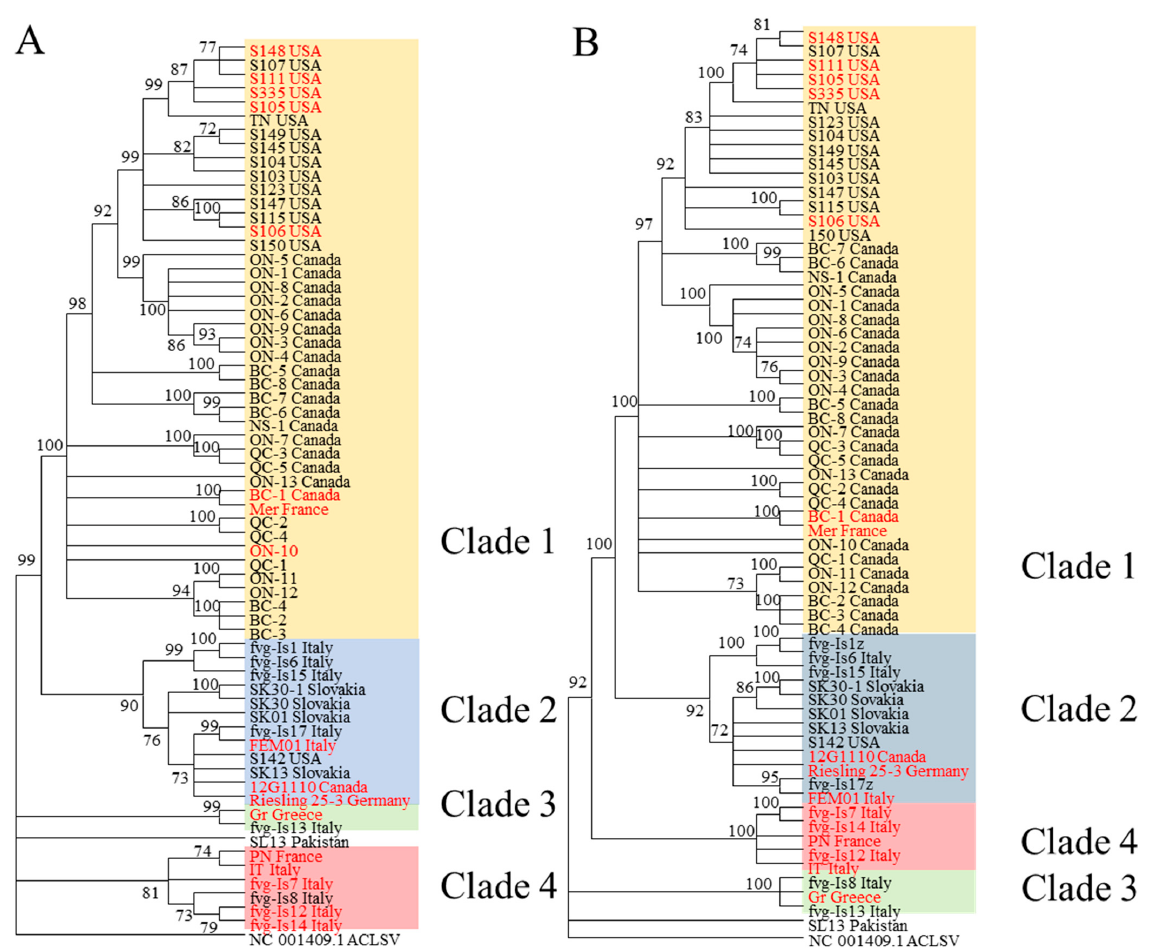
Figure 3. Maximum likelihood model for full genomes ( A /left) and the largest recombination-free fragments 4866 bp ( B /right) from 64 GPGV isolates. Both of these rooted bootstrap-consensus maximum likelihood trees were constructed with MEGA-X (General Time Reversal Model with discreet gamma distribution and invariant sites) and a bootstrap value of 1000, using ACLSV as an outgroup. Branches with less than 70% bootstrap consensus were collapsed. GPGV isolates collected from symptomatic grapevines are written in